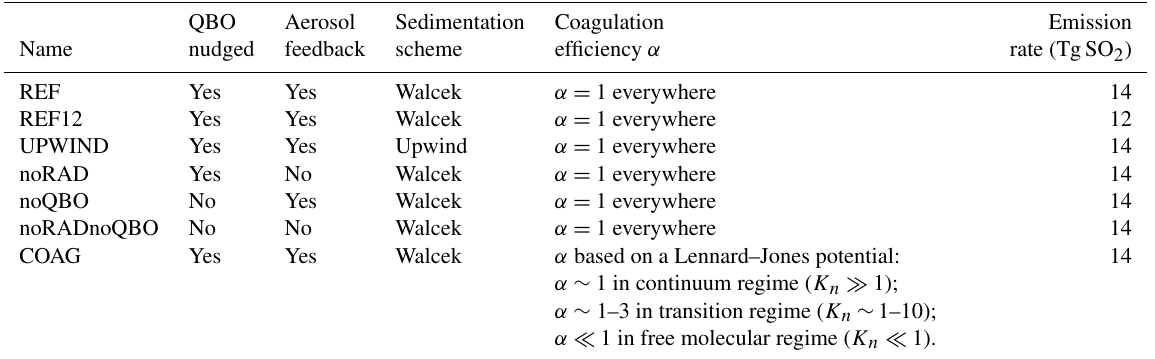
Table 1. List of experiments. QBO Aerosol Sedimentation Coagulation